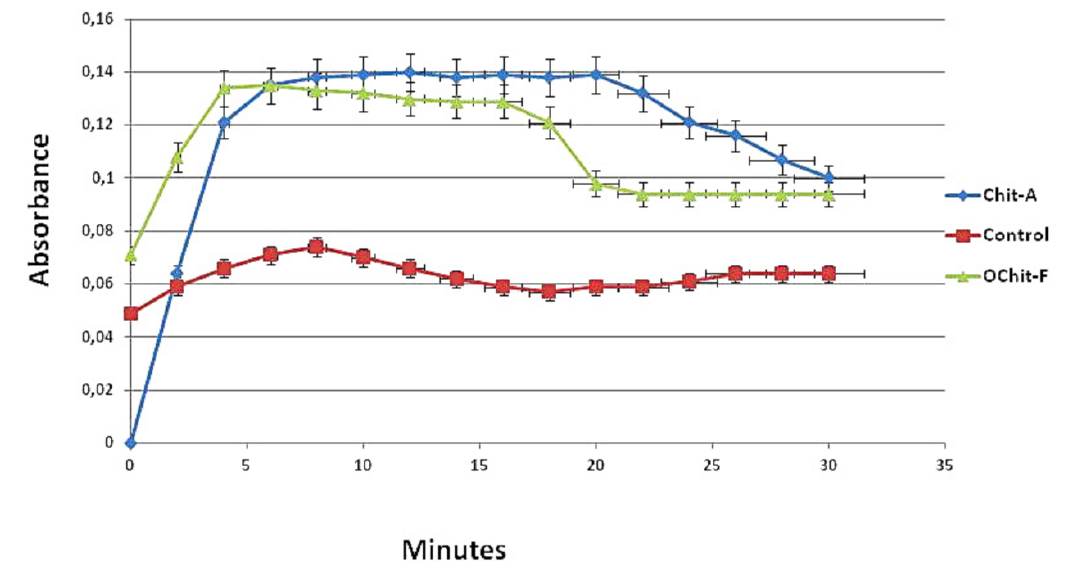
Figure 3. Profile of crystals forming from solutions. Ascending and descending phases of CaOx crystal formation. After 8 min, the formation of the nucleus of the crystals is more intense with Chit-A than that with OChit-F.